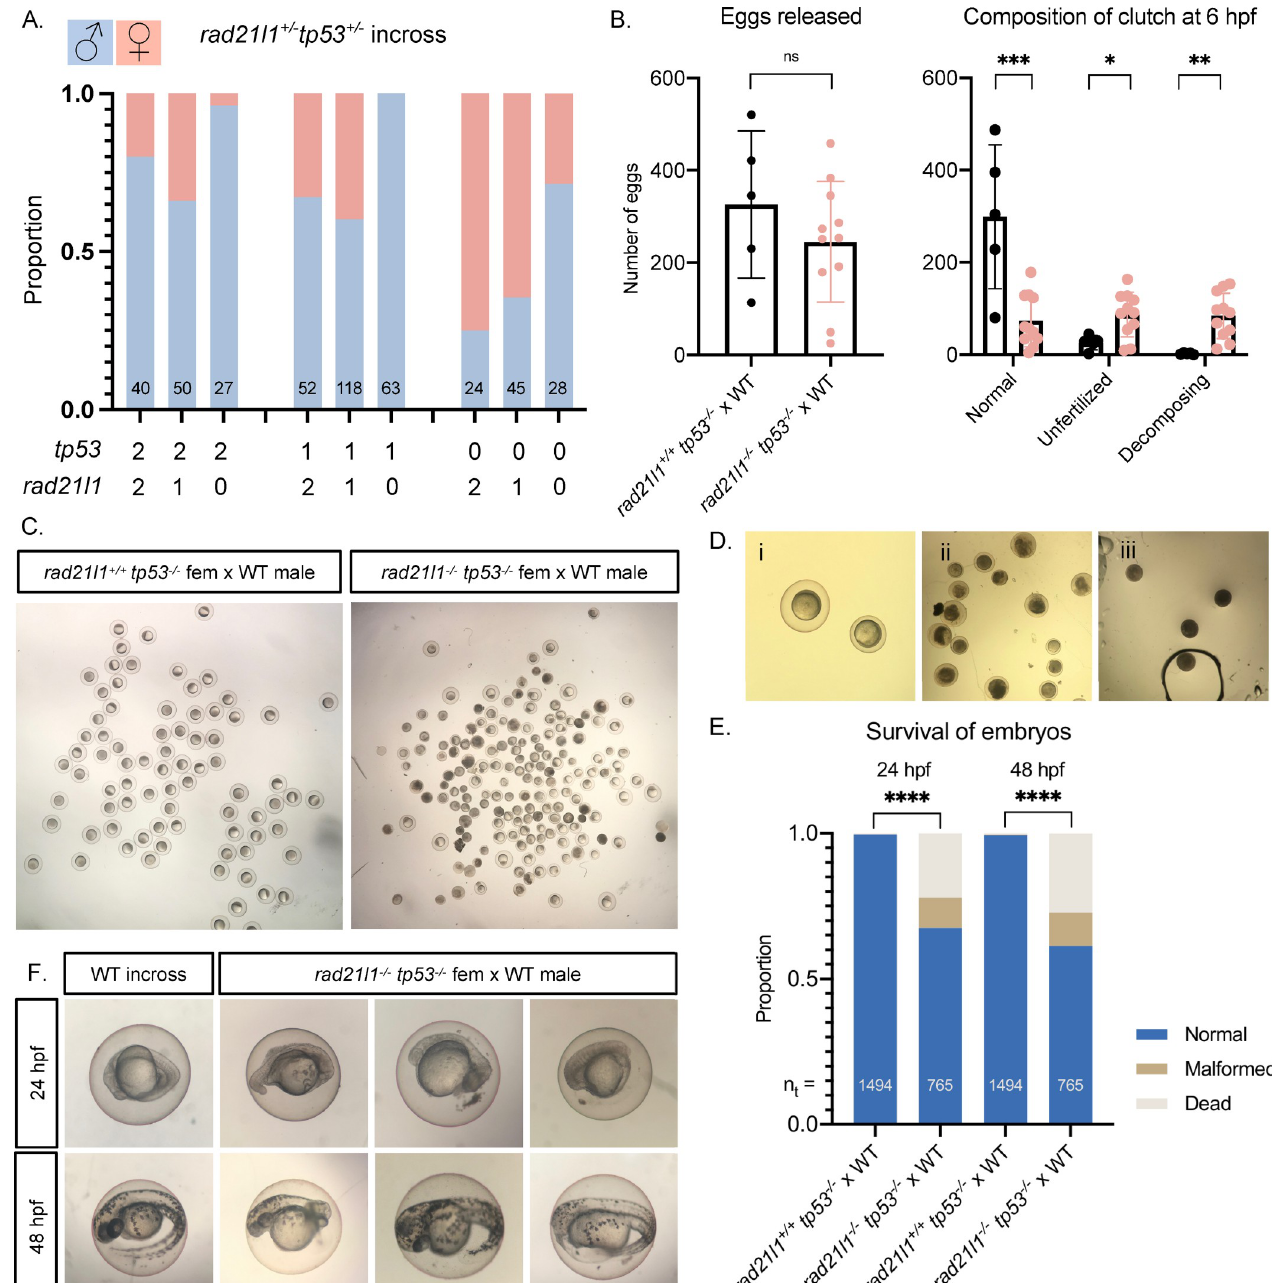
Fig 4. tp53 knockout restores females to rad21l1 mutant population, but rad21l1;tp53 double mutant females produce poor quality eggs and malformed embryos. (A) Sex ratios of all genotypes resulting from a rad21l1 +/- ; tp53 +/- incross. Data pooled from 3 crosses. 0, 1, and 2 on the x-axis refer to the number of wild-type copies of tp53 and rad21l1 . (B) Data resulting from test crosses between rad21l1 -/- ; tp53 -/- females and wild-type males to assess fertility and reproductive phenotype. rad21l1 +/+ ; tp53 -/- female tank mates used as controls. No significant difference in the number of eggs the females released. rad21l1 -/- ; tp53 -/- double mutant females release a significantly greater percentage of eggs that fail to be fertilized or display premature decomposition. (C) Representative images of clutches from double mutant and control females at 6 hpf showing lower overall quality of eggs released from double mutant females. (D) Images i-iii show examples of eggs described in the text at 6 hpf. Panel i shows a normal egg (left) and a tiny egg (right). Panel ii shows prematurely decomposing eggs and panel iii shows opaque eggs. (E) Of normal embryos at 6 hpf, 32.4% are dead or malformed at 24 hpf and 38.7% by 48 hpf. Unpaired, two-tailed student t-test used for statistical analysis. (F) Representative images showing the range of malformations seen in developing embryos from rad21l1 -/- ; tp53 -/- females at 24 and 48 hpf. ns = p > 0.05, � = p < 0.05, �� = p < 0.01, ��� = p < 0.001.